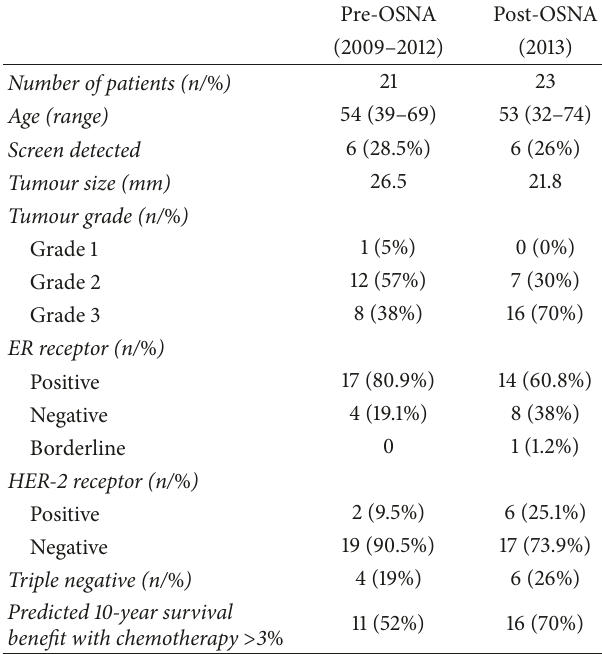
Table 2: Tumour characteristics of patients who underwent adju- vant